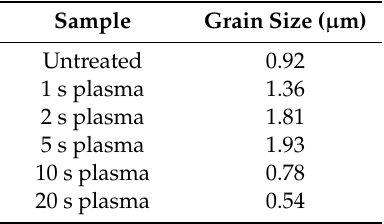
Table 1. Average grain size of the mixed-halide perovskite films before and after plasma treatment.